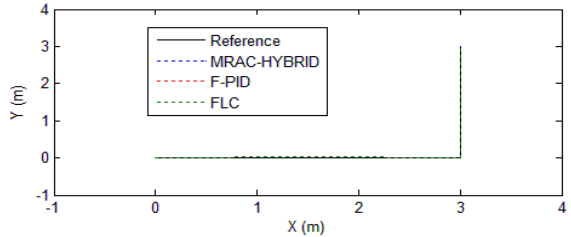
Figure 10. A 2D diagram of the real flight trajectory tracking of UAV with the reference signal, our proposed approach (the MRAC-Hybrid algorithm), the F-PID approach, and the FLC approach.